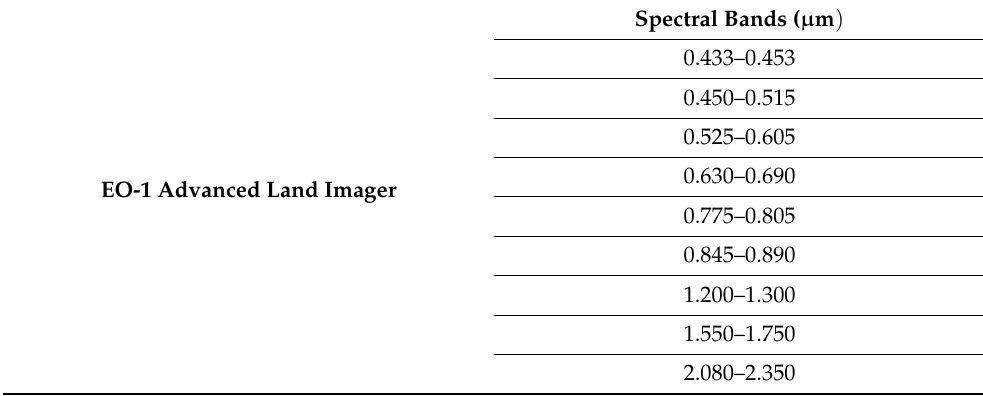
Figure 2. True-color image composite for the real dataset. ( a ) Low-spatial-resolution hyperspectral image; ( b ) High-spatial-resolution pansharpened multispectral image. Table 2. Spectral bands of the EO-1 Advanced Land Imager Sensor